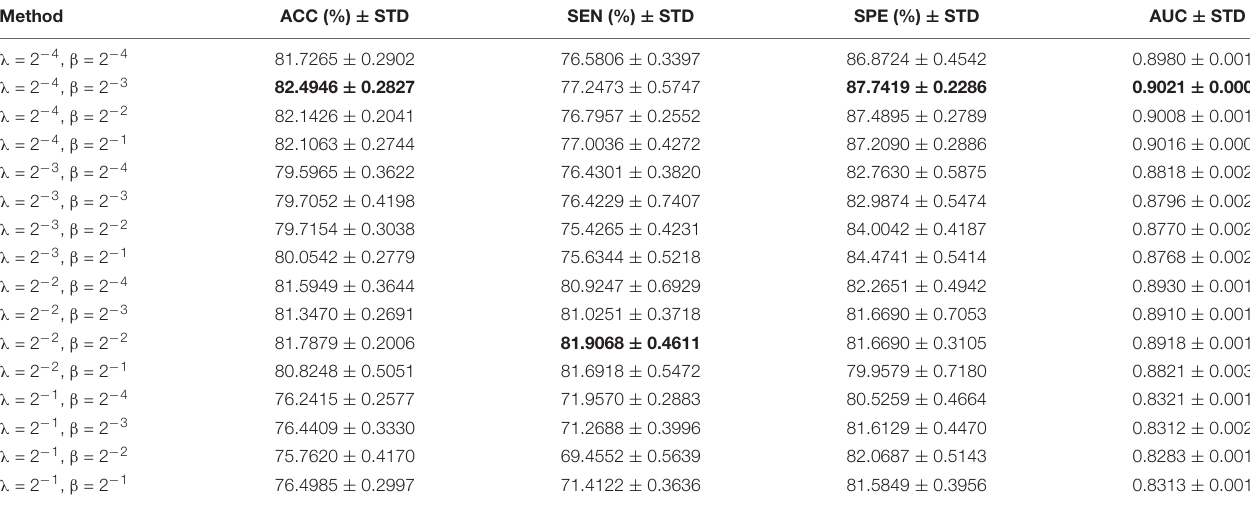
TABLE 4 | Classification performance of different regularization parameter values.